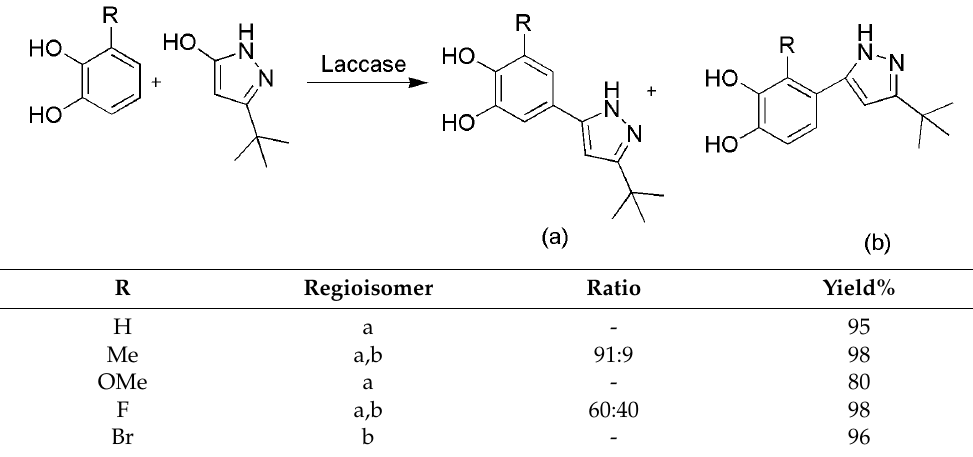
Table 6. The 3-tert-butyl-1H-pyrazol-5(4H)-one containing biaryl compounds obtained by laccase- catalyzed oxidation of catechol.